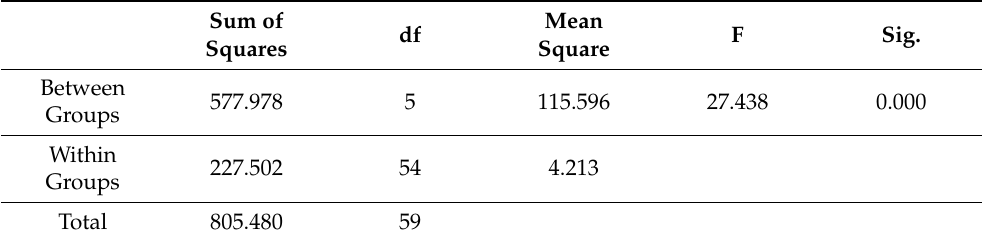
Table 3. One-way ANOVA testing results across the studied groups.